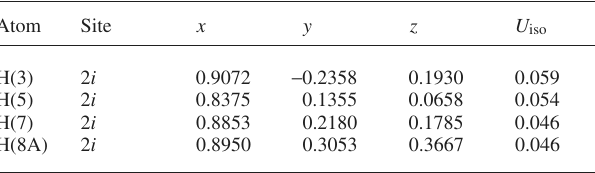
Table 2. Atomic coordinates and displacement parameters (in Å 2 )